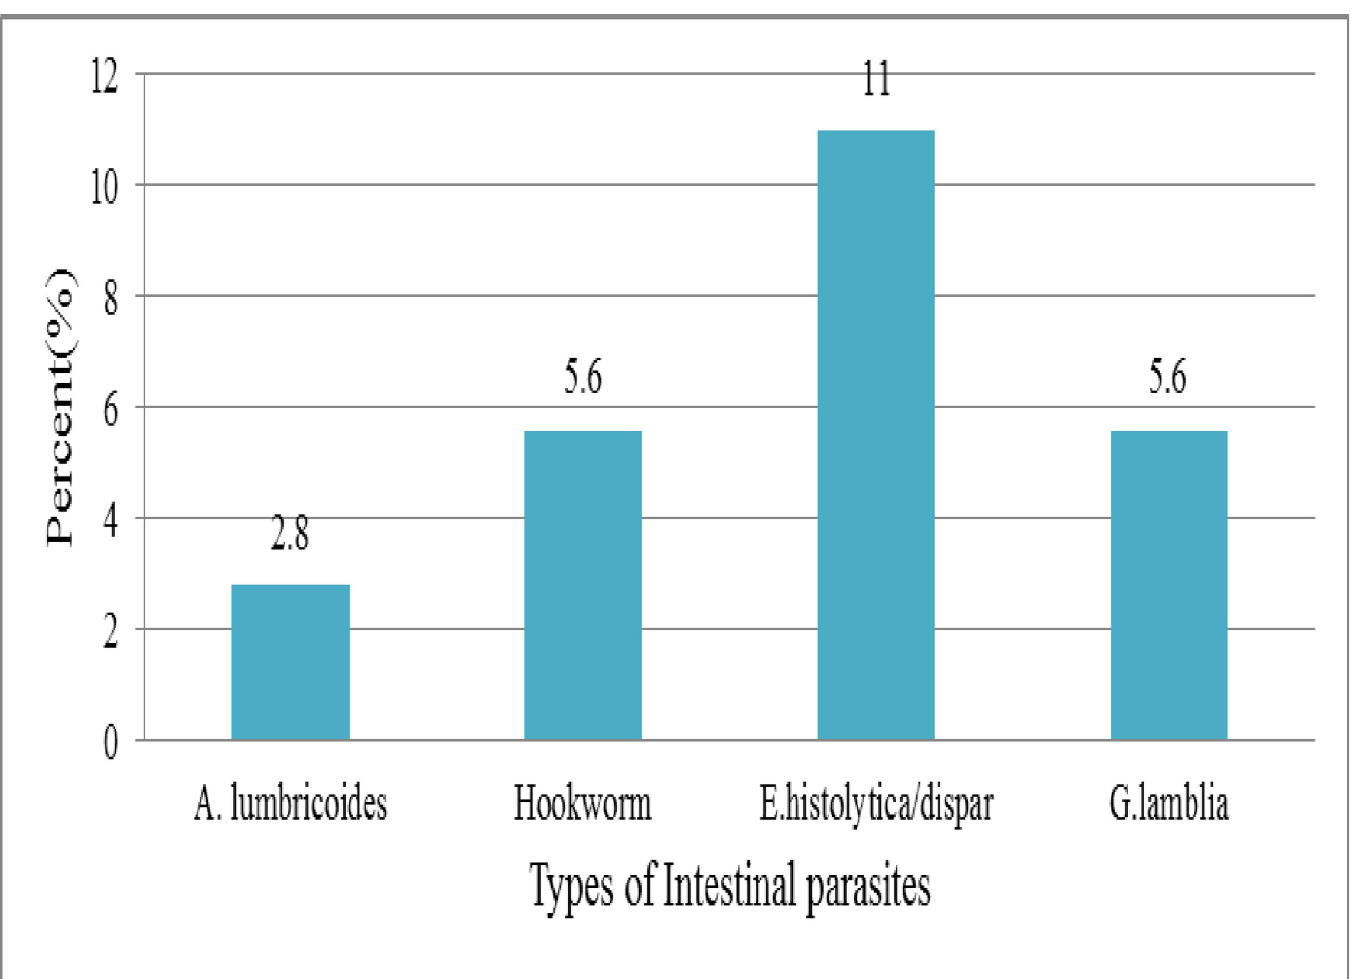
Fig 4. Intestinal Parasite-Tuberculosis co-infection among AFB positive, Kuyu General Hospital, North Shewa, Oromia, Ethiopia, 2020(n = 36).